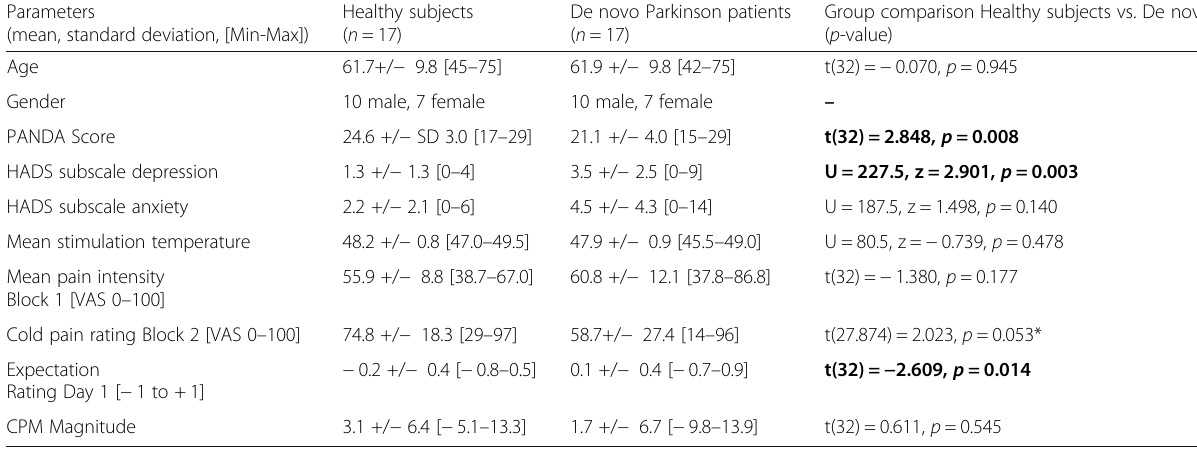
Table 2 Main results for healthy subjects and de novo Parkinson patients (PD) in group comparison